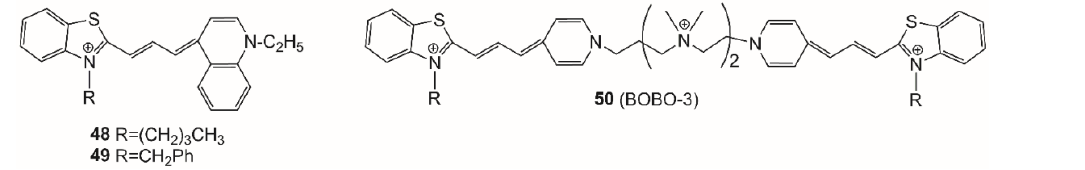
Figure 11. Structures of cyanines 48 – 50 .